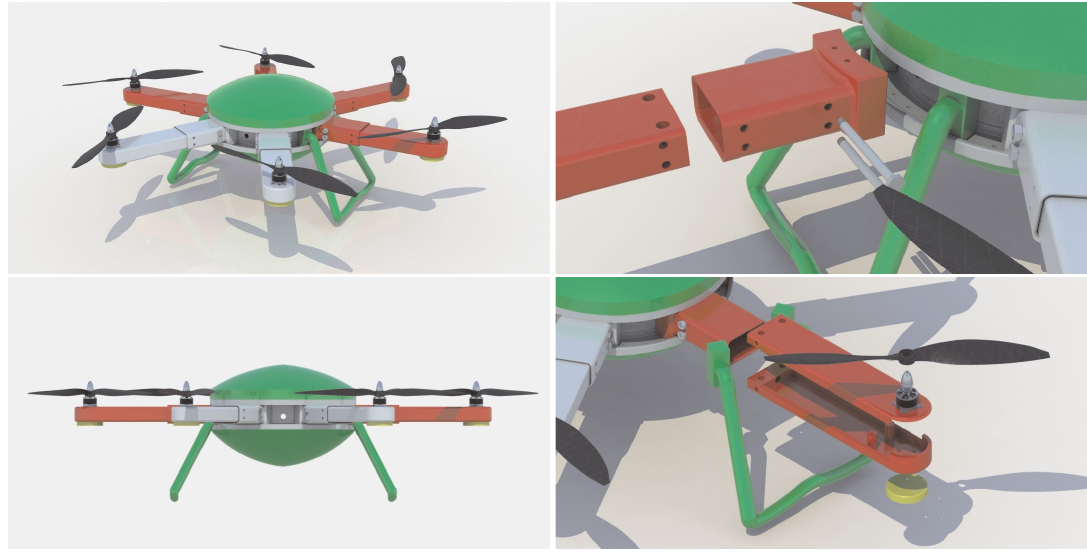
Figure 1: Renderings of several parts and details of the